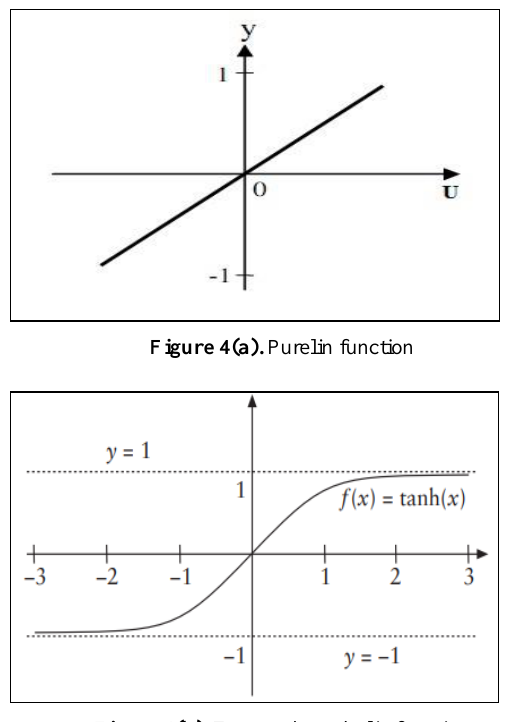
Figure 4(b). Tangent hyperbolic function